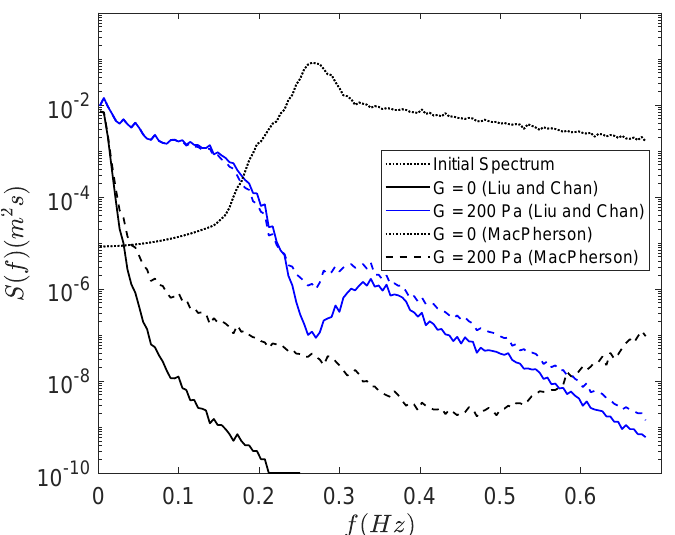
Figure 18. Evolution of random wave spectrum over mud with LC and Macpherson [17] mechanisms, shear moduli G = 0,200 Pa, h = 0.80 m, d m = 0.40 m, ρ m = 1111 kg/m 3 , and ζ =